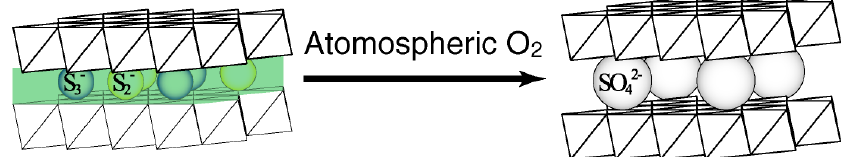
Figure 11. A schematic structure of polysulfide containing MgAl-LDH. Reproduced with permission from reference [81].